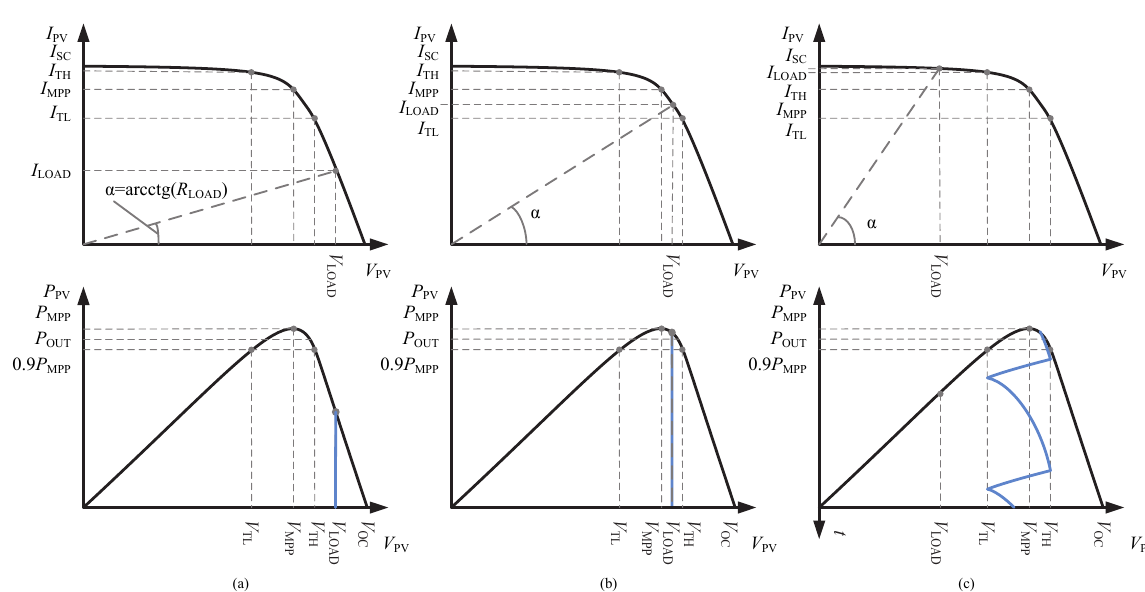
Fig. 3. Optimizer operation modes: out-of-range mode (OR-mode) (a), direct mode (DIR-mode) (b), hysteresis mode (HYS-mode) (c).